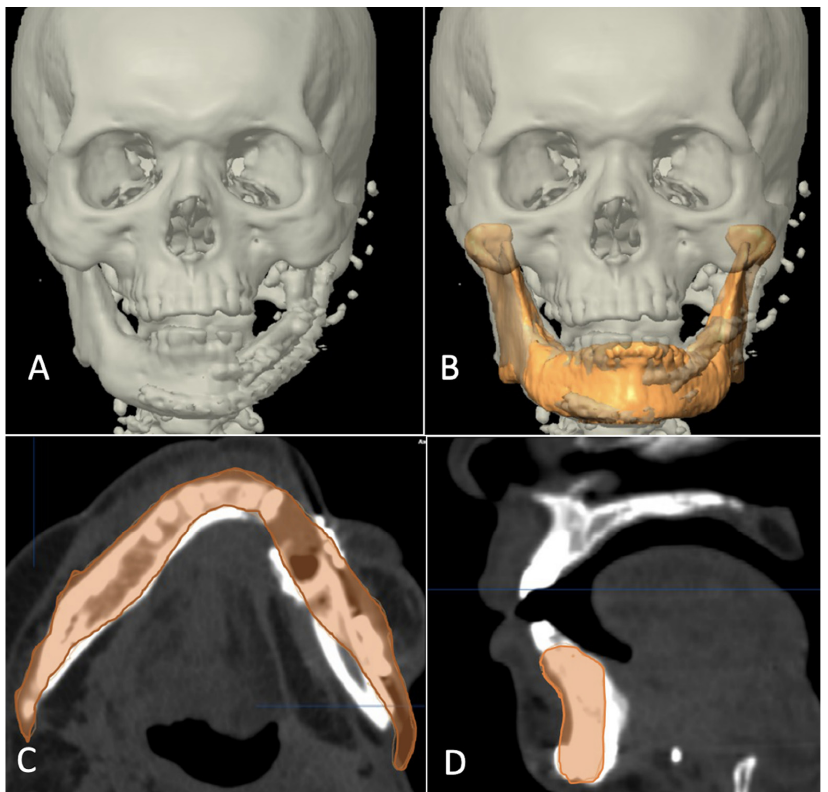
Figure 8. Superimposition of planned and postoperative image in category I. ( A ) 3-dimensional view of outcome after reconstruction. ( B ) Superimposition of virtual plan (orange color) and post-operative data. ( C ) Axial view showing good match of reconstructed fibula to simulated mandible. ( D ) Sagittal view showing good match of reconstructed fibula to simulated mandible.